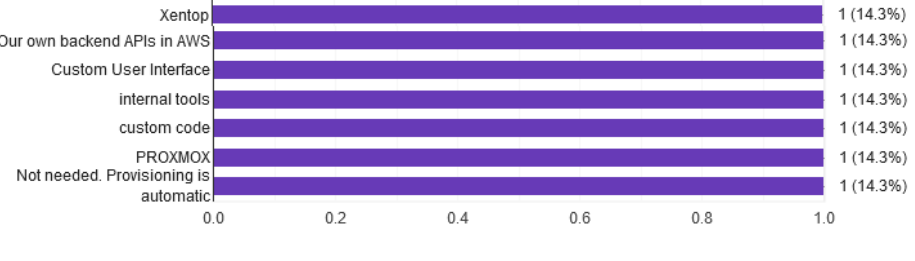
Figure 13. Tools to manage.